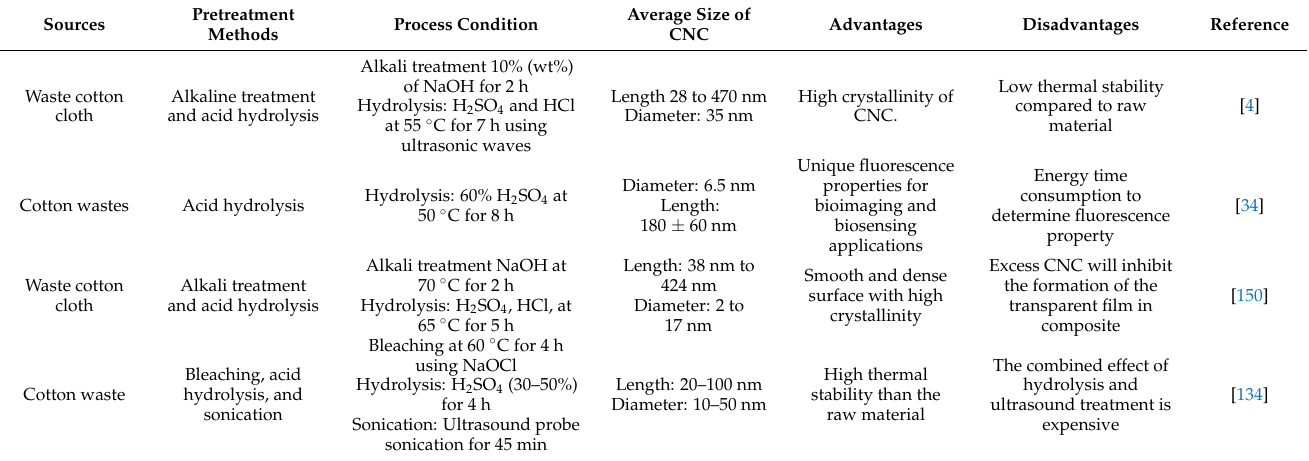
Figure 11. Viscose yarn waste production and one-step extraction of NC from VW [149]. The extraction of CNC from cotton wastes, pretreatment methods, and process con- ditions, including their strength and limitation from the previous studies, is presented in Table 4. Table 4. Cotton wastes and method of extraction of CNC.